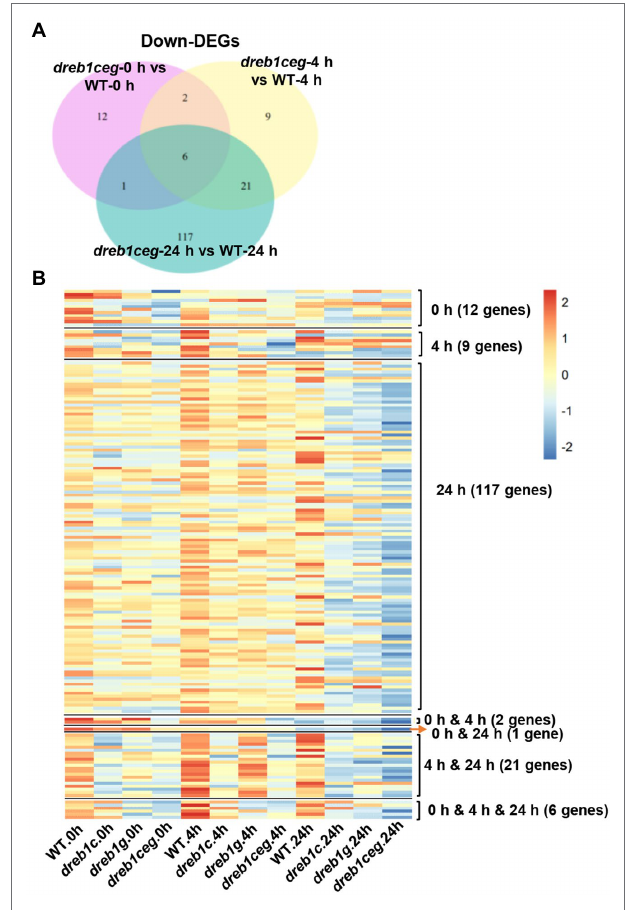
FIGURE 5 | Transcriptome analysis of the dreb1 mutants. (A) Venn diagram indicates the number of downregulated DEGs (fold change ≥ 2, FDR ≤ 0.01) of dreb1ceg versus the WT at 0, 4, and 24 h after chilling treatment at 6 ° C. (B) Heat map of expression levels of 168 OsDREB1C/E/G-activated genes in the WT and the dreb1 mutants at 0, 4, and 24 h after chilling treatment. The OsDREB1C/E/G-activated genes are defined by a reduced expression in dreb1ceg compared to the WT (fold reduction ≥ 2, FDR ≤ 0.01) at any of the three time points. Heat map is plotted using pheatmap package (1.0.12) and ggplot2 (3.3.3) by R language. Venn diagram is plotted using VennDiagram package (1.6.20) by R